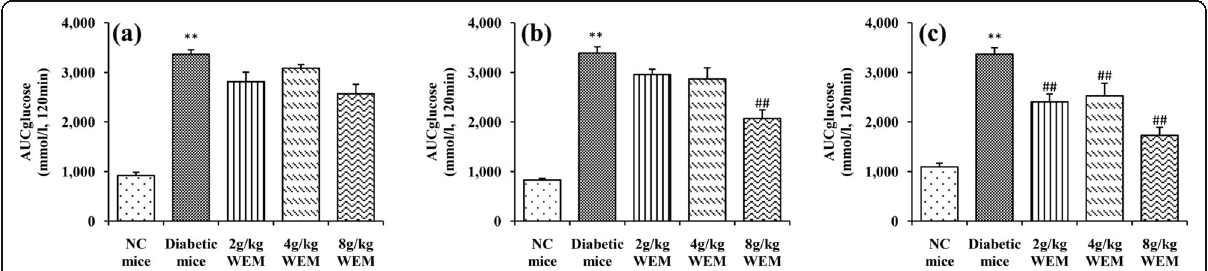
Fig. 3 Area under the curve for glucose (AUC glucose) was calculated using DAS software in the 6th ( a ), 8th ( b ) and 10th ( c ) week starting from the treatment. Results are means ± SEM ( n = 6). * P < 0.05, ** P < 0.01, NC mice vs. Diabetic mice; # P < 0.05, ## P < 0.01, WEM vs. Diabetic